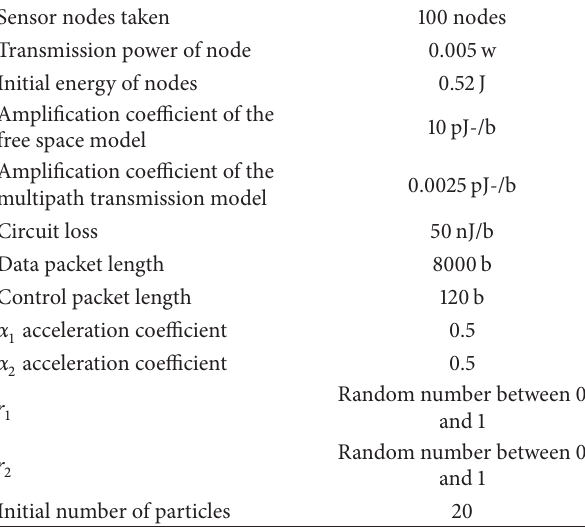
Table 1: Simulation